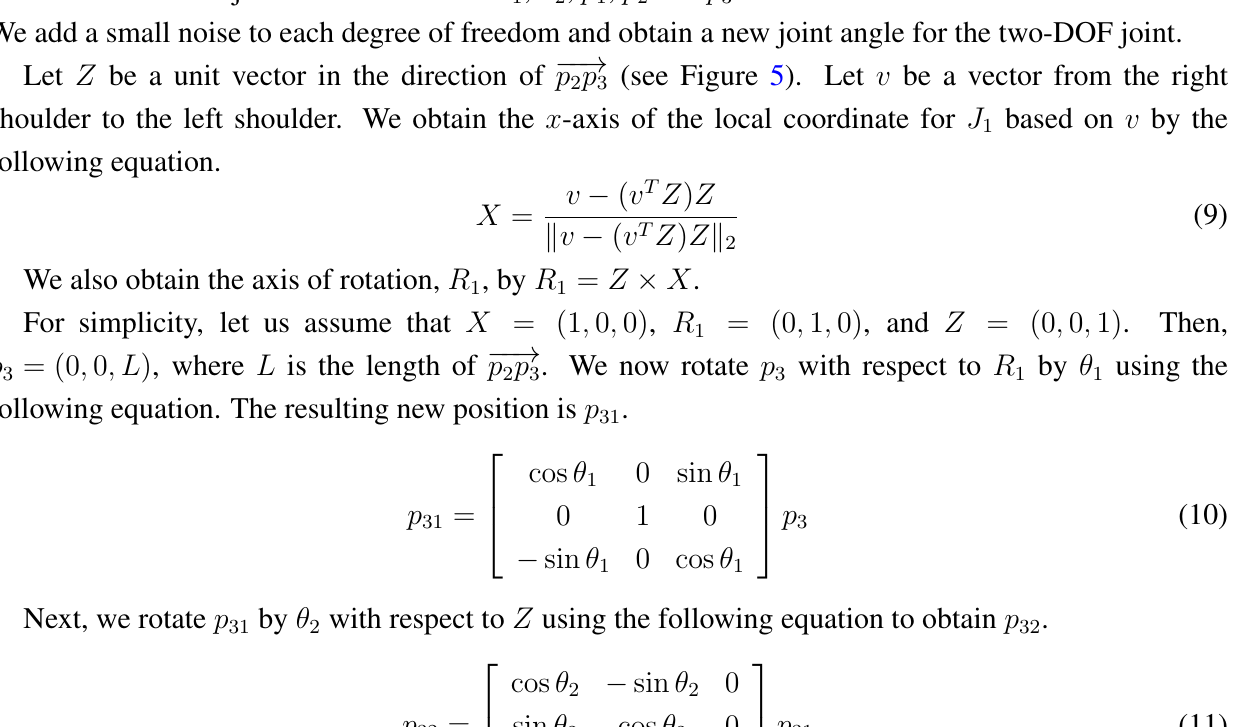
p p , with respect to R 1 2 3